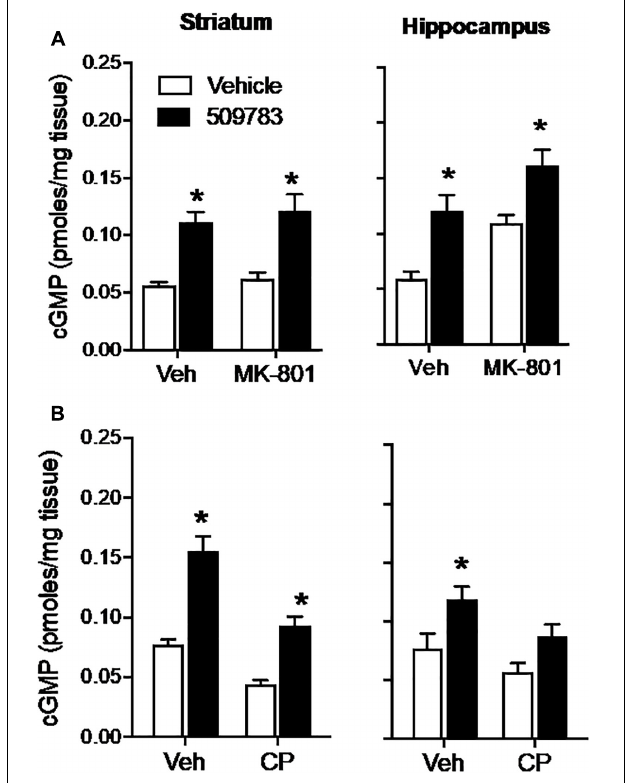
FIGURE 2 | Inhibition of glutamate receptors only slightly attenuated the increase in cGMP induced by PDE9A inhibition. The NMDA receptor antagonist MK-801 (1.0 mg/kg) or the AMPA receptor antagonist CP-465022 (CP, 10 mg/kg) were administered 20 min before administration of PF-509783 (32 mg/kg) and animals were sacrificed 30 min later. MK-801 alone caused an increase in hippocampal cGMP (A) , whereas CP-465022 reduced cGMP in both brain regions (B) . PF-509783 elevated cGMP levels in both brain regions in the absence or presence of the glutamate receptor antagonists. Results were analyzed by two-way ANOVA (PDE9A inhibitor X receptor antagonist) in each brain region followed by post hoc tests of the effect of the PDE9A inhibitor after vehicle or drug, corrected for multiple comparisons. MK-801 (A) . In the striatum, there was a significant main effect of PF-509783 [ F (1, 20) = 41.96, P < 0.0001), but not a main effect of MK-801 [ F (2, 20) = 0.769, P = 0.391) or an interaction [ F (2, 20) = 0.032, P = 0.8596). Subsequent